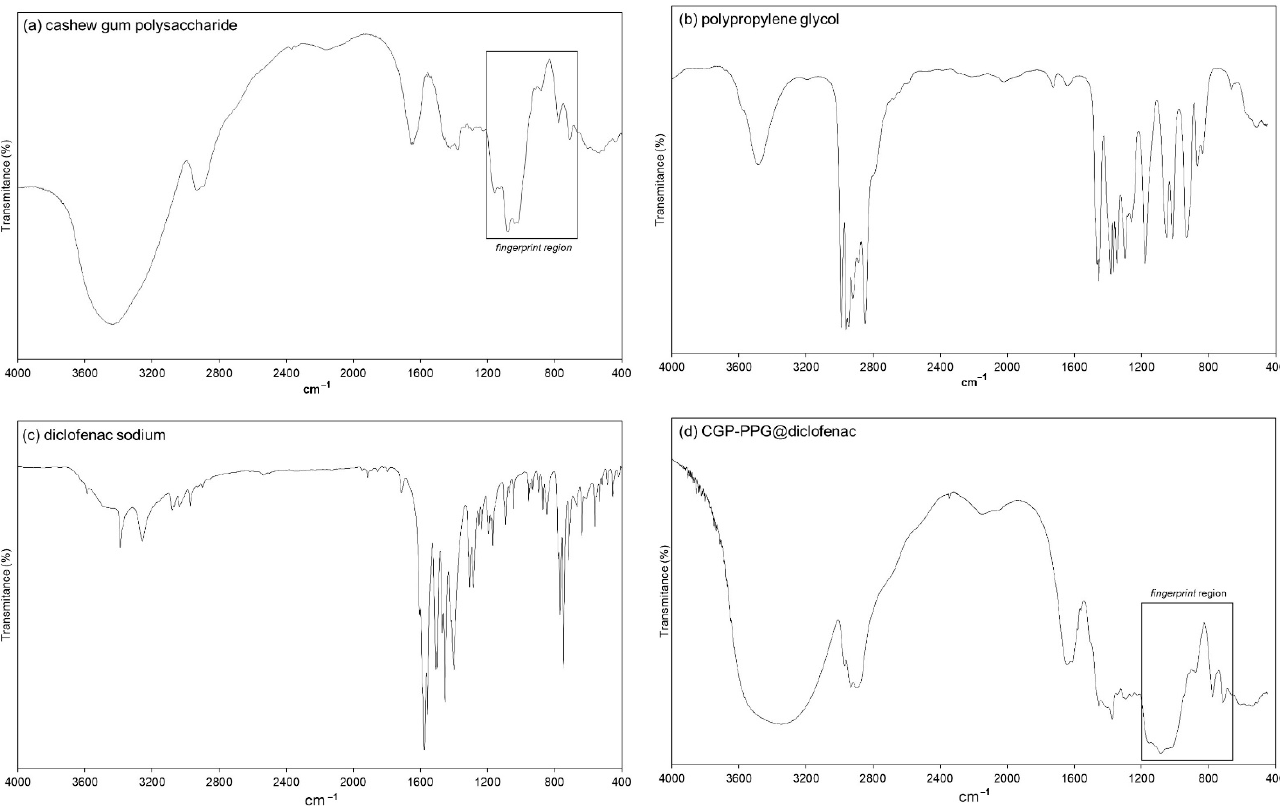
Figure 5. FTIR spectra of ( a ) cashew gum polysaccharide (CGP), ( b ) polypropylene glycol (PPG), ( c ) diclofenac sodium, ( d ) CGP-PPG@diclofenac and ( d ) CGP-PPG@diclofenac nanoparticles.